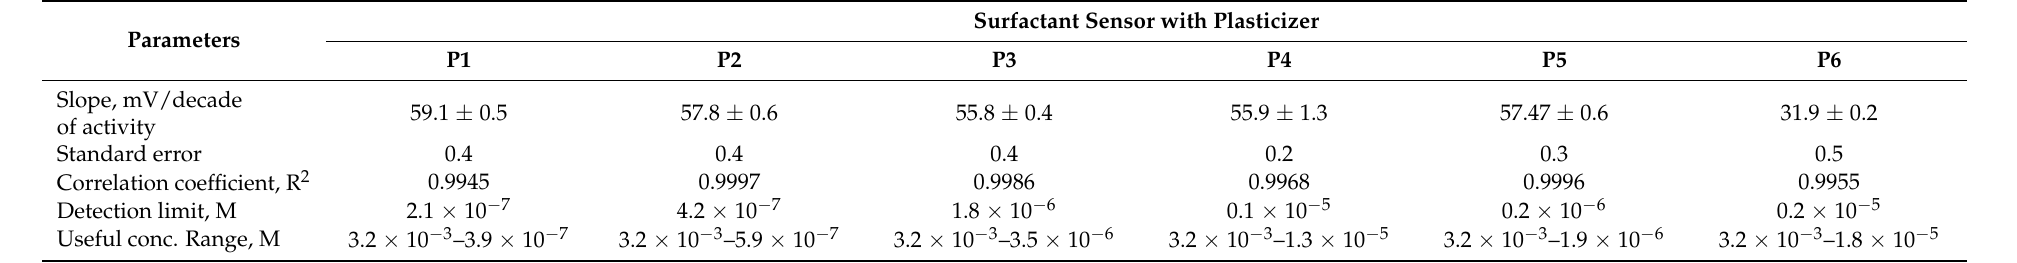
Table 3. Statistics of the response characteristics of the P1–P6 surfactant sensors on CPC, given together with ± 95% confidence limits.